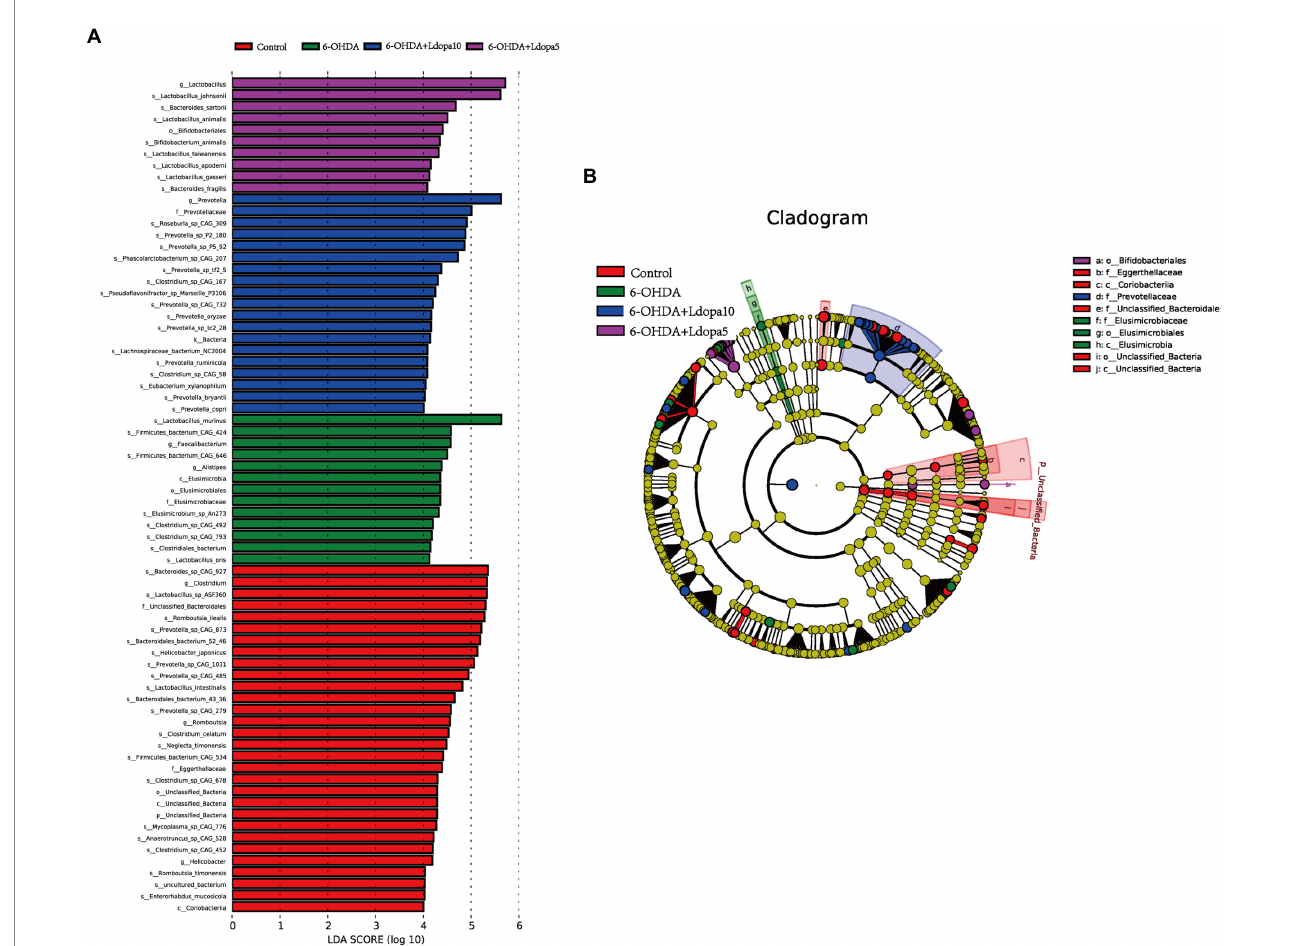
FIGURE 3 LEfSe comparison of gut microbiome was performed. Only taxa meeting an LDA significance threshold >4 were shown in the figures, namely, the biomarker with statistical difference among groups. (A) LDA scores of gut microbiota for the 6-OHDA, 6-OHDA+Ldopa5, 6-OHDA+Ldopa10 and control groups, the length of the bar chart represents the LDA Score. (B) Evolutionary branching diagram of the LEfSe results for the 6-OHDA, 6-OHDA+Ldopa5, 6-OHDA+Ldopa10 and control groups, circles radiating from inside out represent taxonomic levels from phylum to species, each small circle at a different classification level represents a classification at that level, and the size of the small circle diameter is proportional to the size of the relative abundance. The taxa with no significant difference were uniformly colored yellow, and the biomarkers were colored with the following groups, the taxa names represented by letters are shown on the right of the